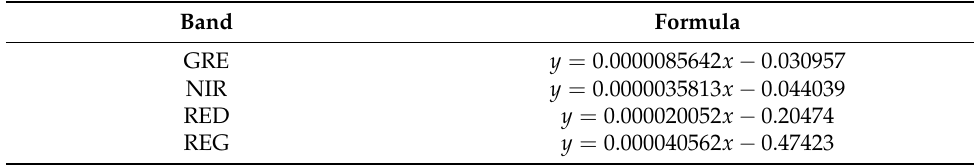
Table 1. Calibration equation for the multispectral